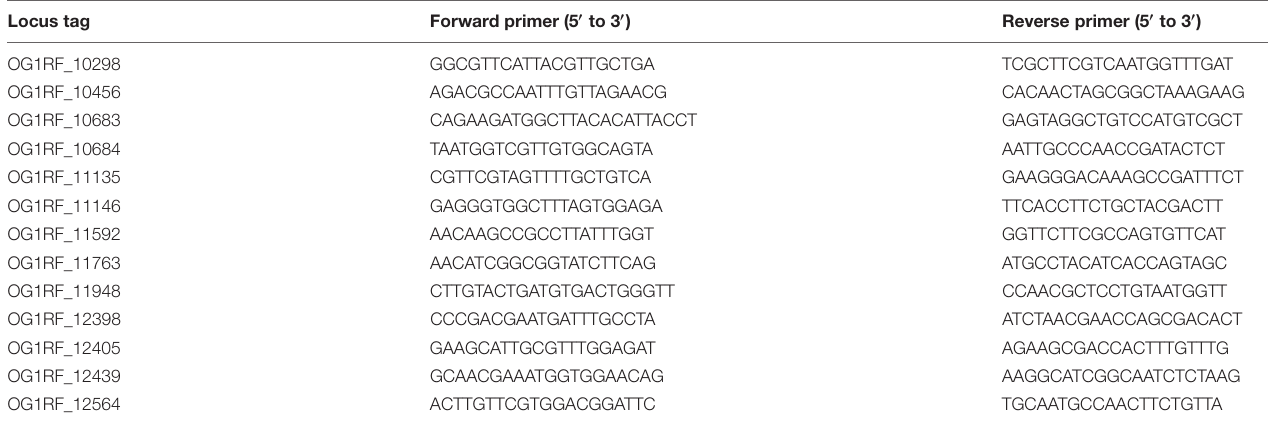
TABLE 2 | Oligonucleotides used in qRT-PCR assays. Locus tag Forward primer (5 (cid:2) to 3 (cid:2)